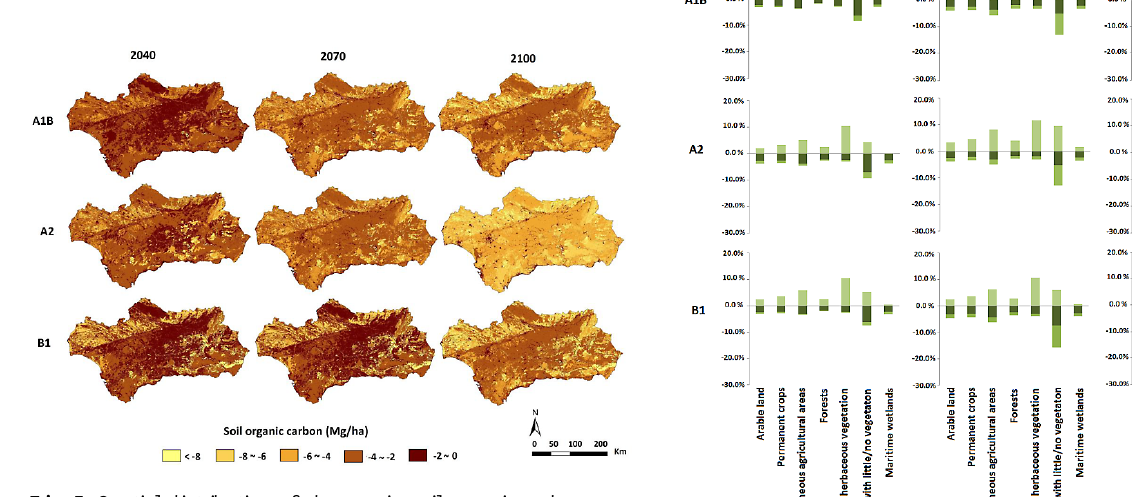
Fig. 5. Spatial distribution of changes in soil organic carbon con- tent (Mgha − 1 ) in Andalusia (southern Spain) for different SRES scenarios and different periods (2040, 2070, 2100).